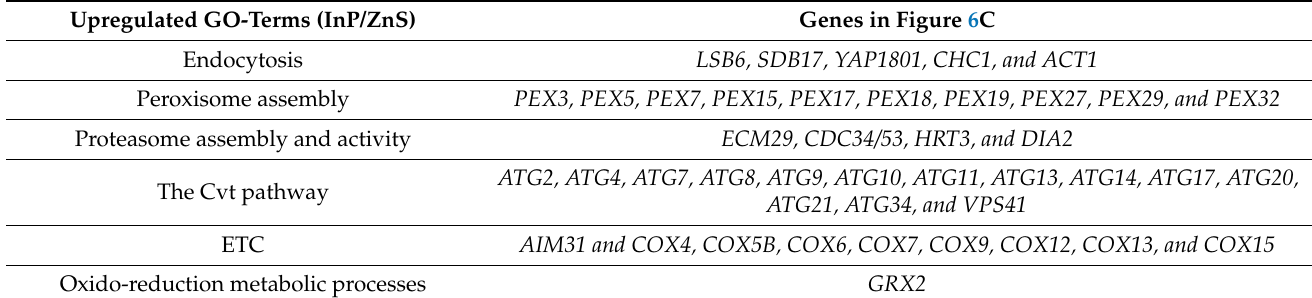
Figure 7. A proportionately accurate Venn-diagram that represents the number of up- and downregulated genes whose expression has been significantly changed when exposed to CdSe/ZnS QDs or InP/ZnS QDs. The overlapped segments of each Venn-diagram represent genes that are differentially expressed when exposed to CdSe/ZnS and InP/ZnS QDs. The portions of the Venn-diagram that do not overlap are up- or downregulated genes that become differentially expressed only when exposed to CdSe/ZnS QDs or InP/ZnS QDs. ( A ) Every gene whose expression was significantly increased when compared to the normal gene expression in yeast cells when exposed to CdSe/ZnS or InP/ZnS QDs. ( B ) Every gene whose expression was significantly decreased when exposed to CdSe/ZnS or InP/ZnS QDs. Table 5. A table listing the GO-terms and genes in Figure 6C. It represents the multiple upregulated cellular processes and genes in yeast exposed to 100 µ g/mL InP/ZnS QDs. All genes incorporated in this table exhibited expression levels significantly higher than expression levels of NTC